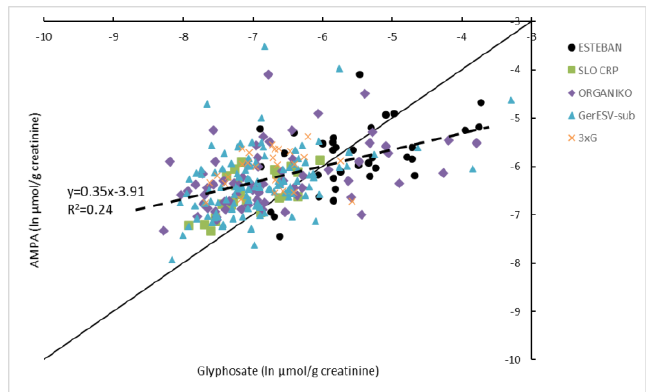
Figure 3. HBM4EU harmonized data (Belgium (3XG), Cyprus (ORGANIKO), Germany (GerES V-sub), Slovenia (SLO_CRP), France (ESTEBAN)) for glyphosate and AMPA in children. Data (>LOQ) are expressed on a natural logarithmic scale and corrected for creatinine. The 1:1 line (full line) is indicated. See also [8] for more information on the children’s studies.